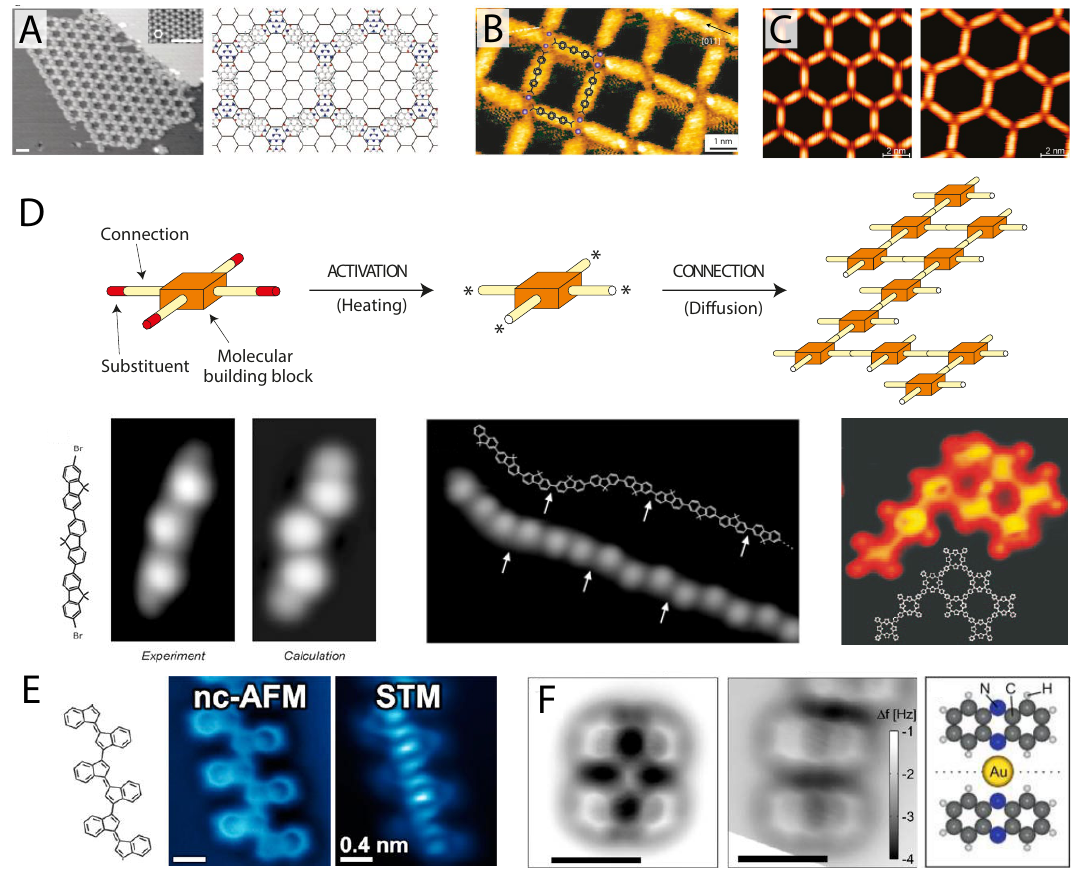
Figure 4. Potential for submolecular imaging of supramolecular systems. ( A ) STM image of a complex porous hydrogen bonded network comprising a mixed phase of perylene tetra-carboxylic di-imide (PTCDI) and melamine (reprinted by permission from Macmillan Publishers